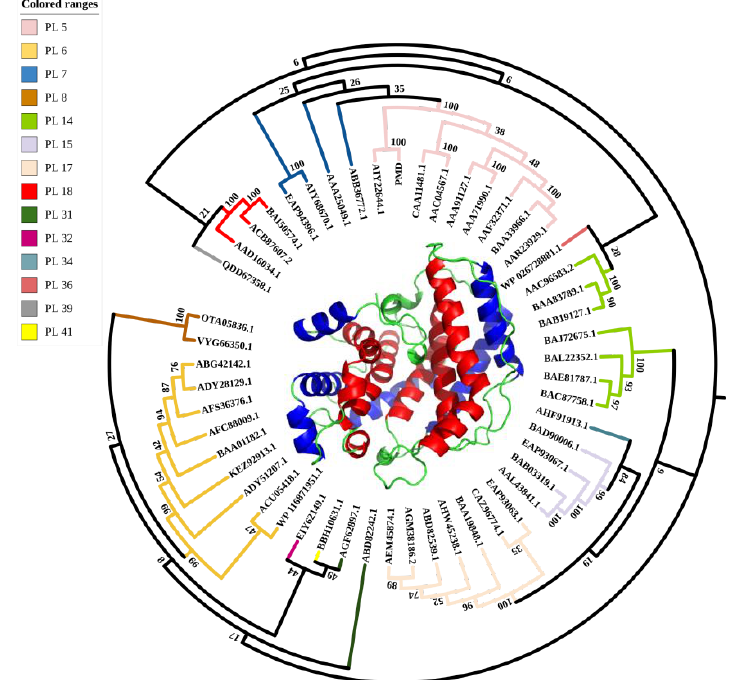
Figure 1. Phylogenetic tree analysis of reported alginate lyases from various microorganisms. The numbers at the branching points were the bootstrap values. The color of the branches indicated the classification of alginate lyases. The tree was created by the neighbor-joining method with MEGA-5 software and further modified via the ITOL web service. The structure of the novel alginate lyase (PMD) was prepared using the SWISS-MODEL web server and colored in the rule (inner helix: red, outer helix: blue, and others: green).